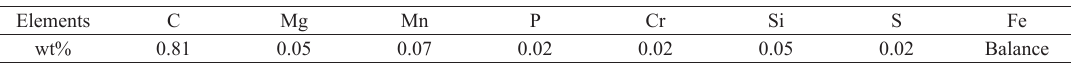
Table 2. Composition (wt%) of eutectoid steel powder.